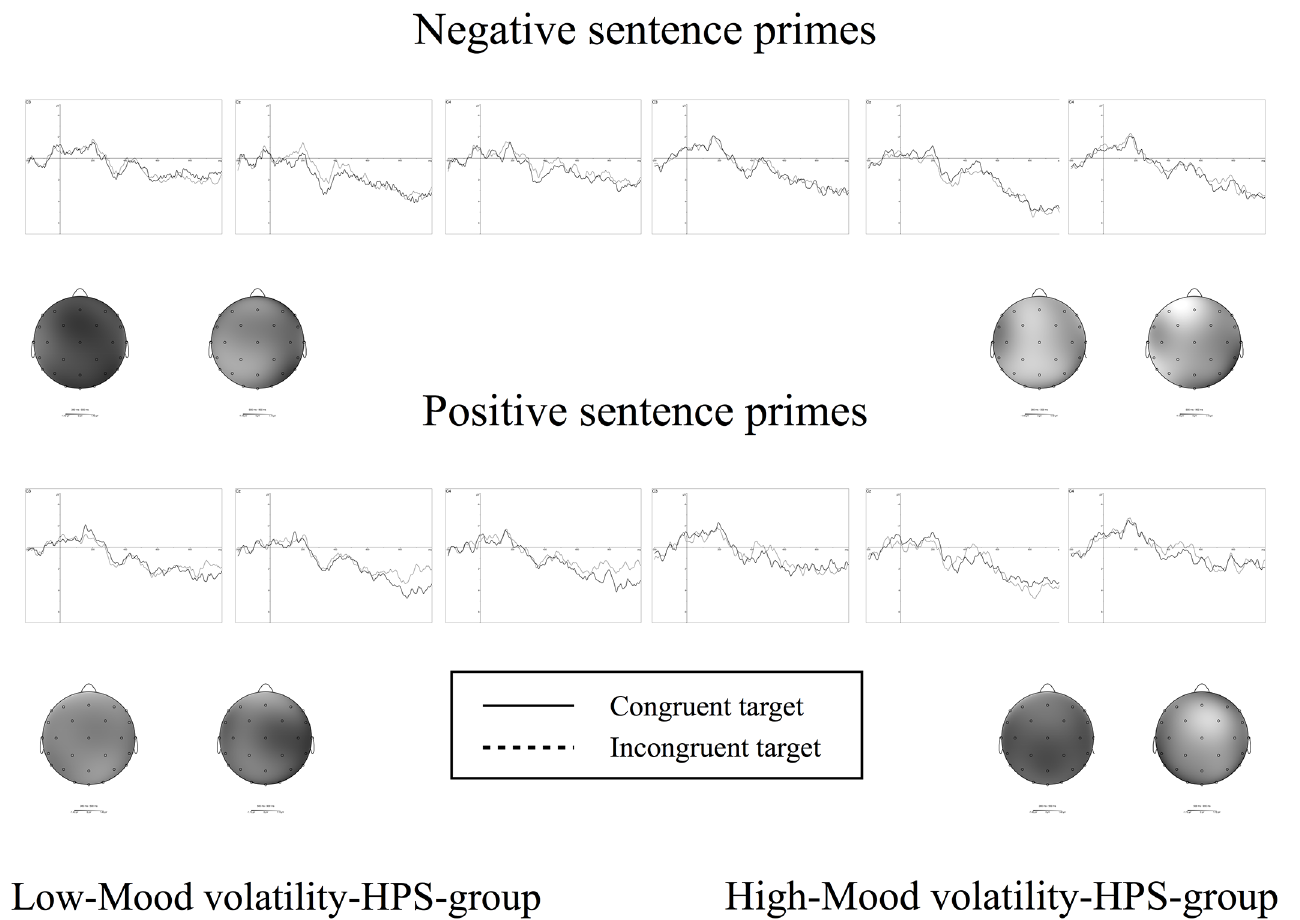
Fig 2. ERPs for the three central electrodes and topographical representations for the Low Mood Volatility-HPS and the High Mood Volatility-HPS as a function of type of Emotional valence and Congruency.